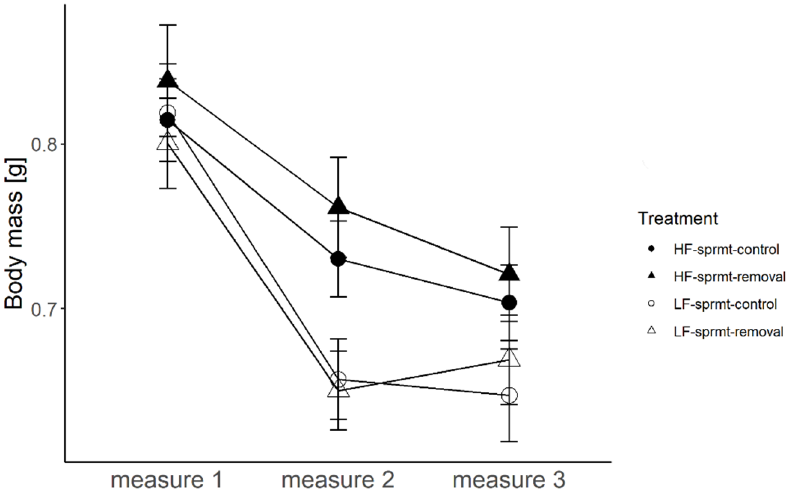
Figure 1. Change in body mass of males exposed to high and low feeding treatments (HF and LF), with and without experimental spermatophore removal (respectively, sprmt-removal and sprmt-control) measured at three time points (measure 1, before the start of the experimental food treatments, measure 2 before the start of the spermatophore removal treatment, measure 3 at the end of the spermatophore removal treatment) before and after the spermatophore removal treatment. Table 1. Results of statistical models (GLMs unless specified) showing the effect of food treatment (high-fed and low-fed), experimental spermatophore removal (removal and control), their interaction, and the time points for body mass measures (measures 2 and 3) on male responses indicating investment in (i) soma maintenance (change in body mass), (ii) future reproduction (spermatophore production and sperm viability), and (iii) survival (% males surviving at the end of the experimental treatment) and longevity (number of days alive). Significant effects are shown in italics.